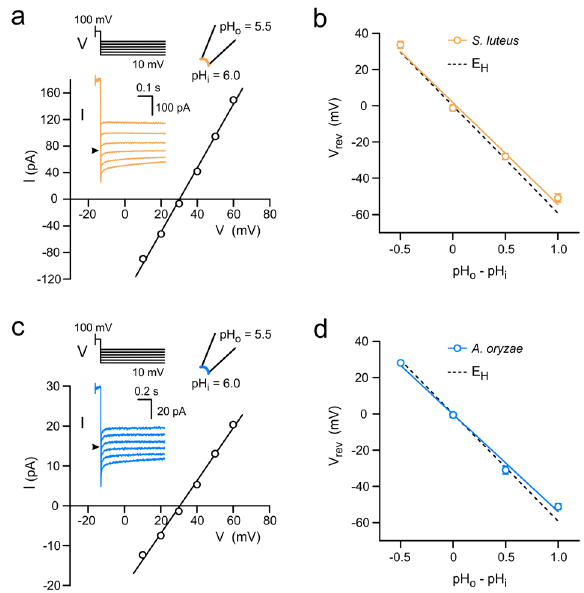
Fig. 2 Hv1s from S. luteus and A. oryzae are proton selective. a Example of measurement of reversal potentials ( V rev ) for SlHv1-mediated currents in the presence of a transmembrane pH gradient ( Δ pH = pH o − pH i ) of 0.5. Currents were measured at the indicated voltages after a depolarization step to 100 mV. Black arrowhead in inset indicates 0 pA. b V rev as a function of Δ pH; slope of linear fi t: − 56 ± 4 mV/pH unit. E H , displayed in dashed line, is the Nernst potential for protons and indicates perfect proton selectivity (slope: − 58.9 mV/pH unit). c Same as ( a ) but for AoHv1. d Same as ( b ) but for AoHv1; slope of linear fi t: − 54 ± 3 mV/pH unit. Δ pH of − 0.5, 0, 0.5, and 1, in ( b ) and ( d ) correspond to the following (pH i , pH o ) pairs: (6.5, 6.0), (6.0, 6.0), (6.0, 6.5), and (5.5, 6.5), respectively. Each point in ( b ) and ( d ) represents the average of 3 – 4 independent measurements ± SEM. Error bars are not shown where smaller than